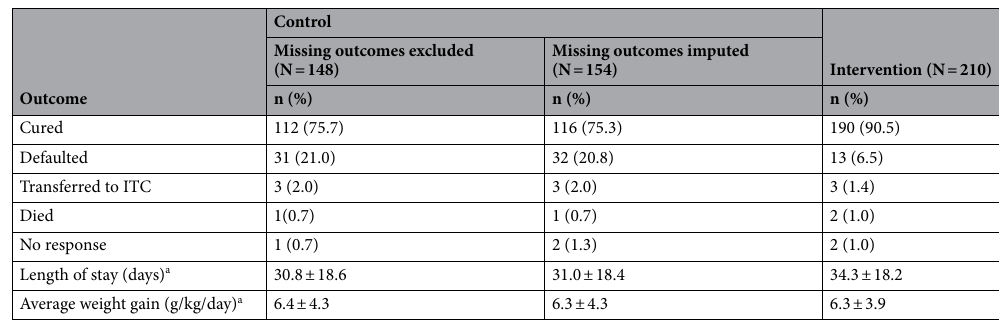
Table 2. Treatment outcomes. a Applies to cured children only. Data presented as Mean ±